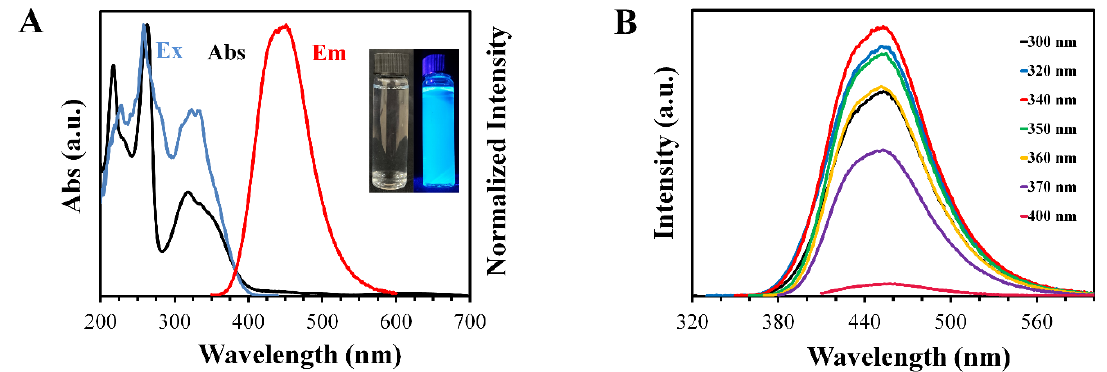
Figure 4. ( A ) Excitation (blue), absorption (black), and emission (red) spectra of the CNDs (inset: digital picture of the CND solution under visible light (left) and ultraviolet light (right)). ( B ) PL emission of CNDs with various excitation wavelengths.